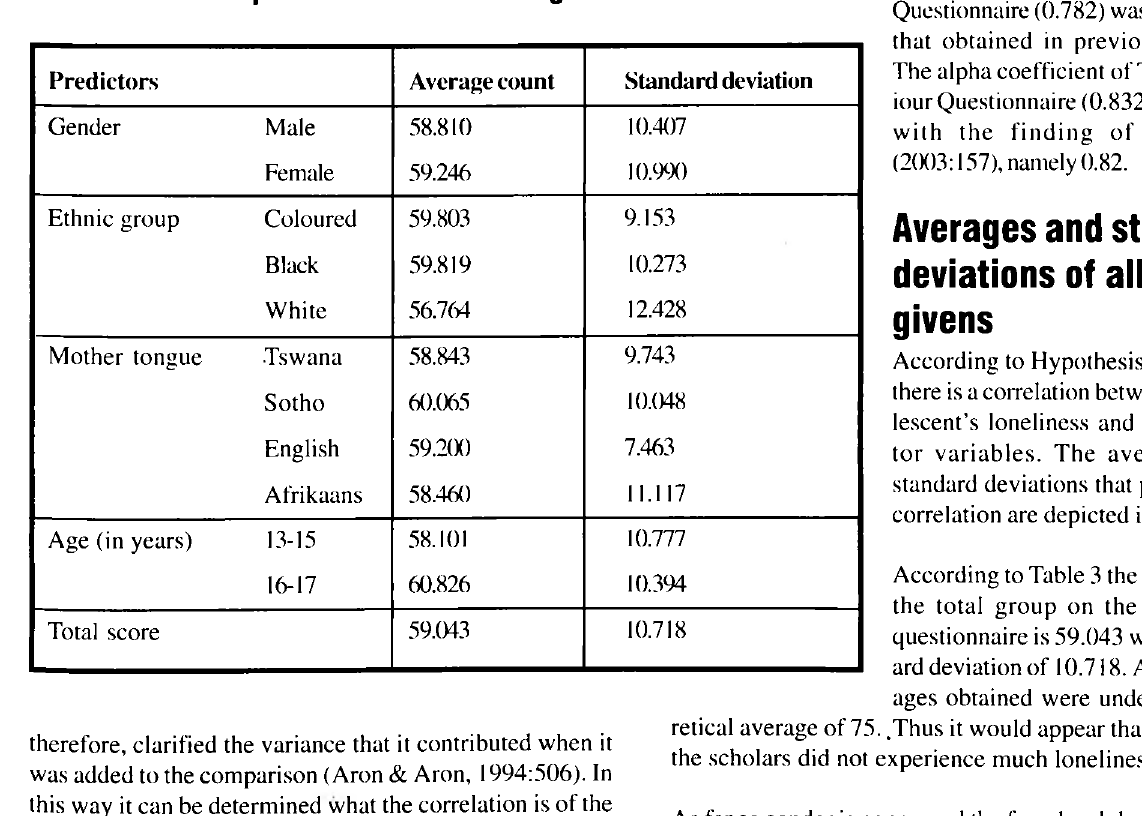
Table 3: Averages and standard deviations of the biographical variables with respect to loneliness amongst